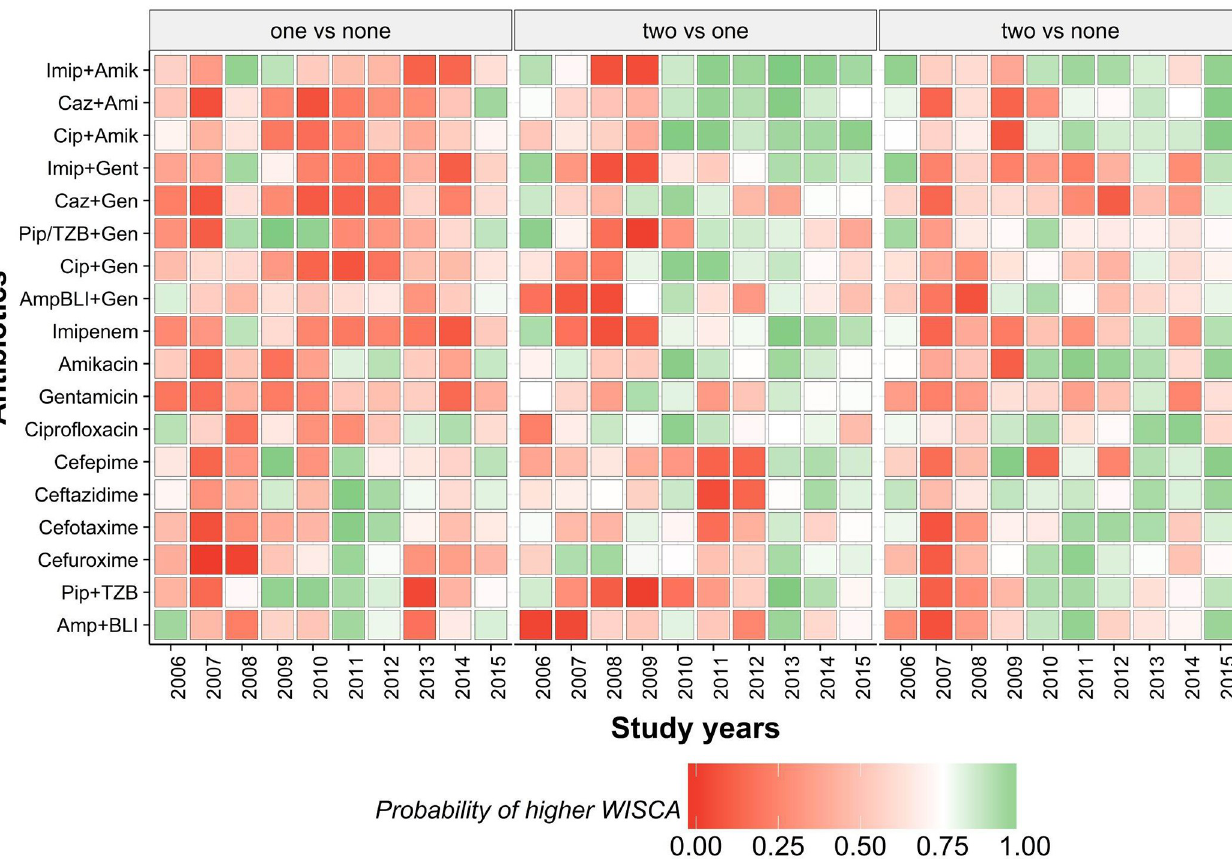
Fig 10. Probability that Bayesian WISCA of the antibiotic choice at the particular year is superior in the departments "x" compared with department "y" (departments are stratified according to the number infection control policy adherence).